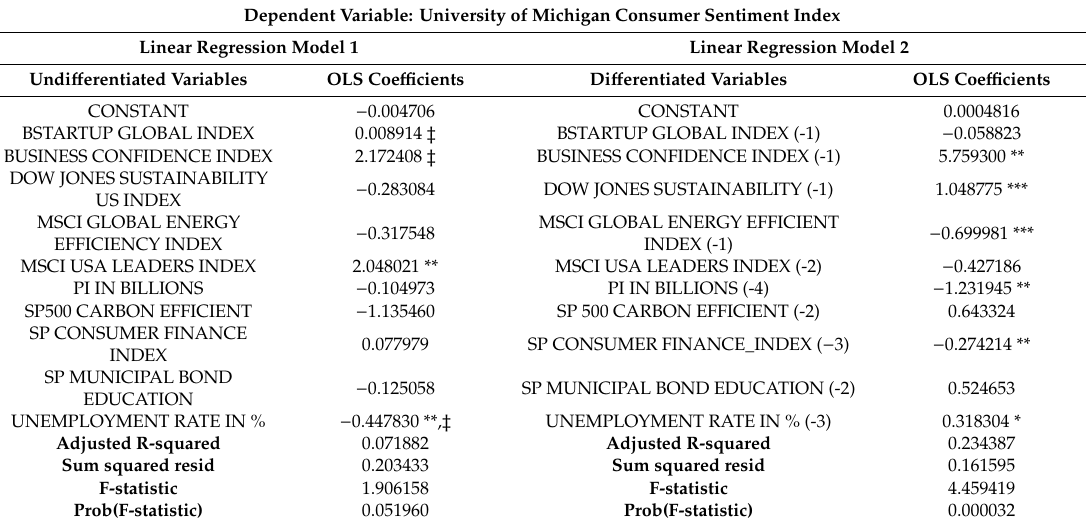
Table 2. Results of regression analysis—base